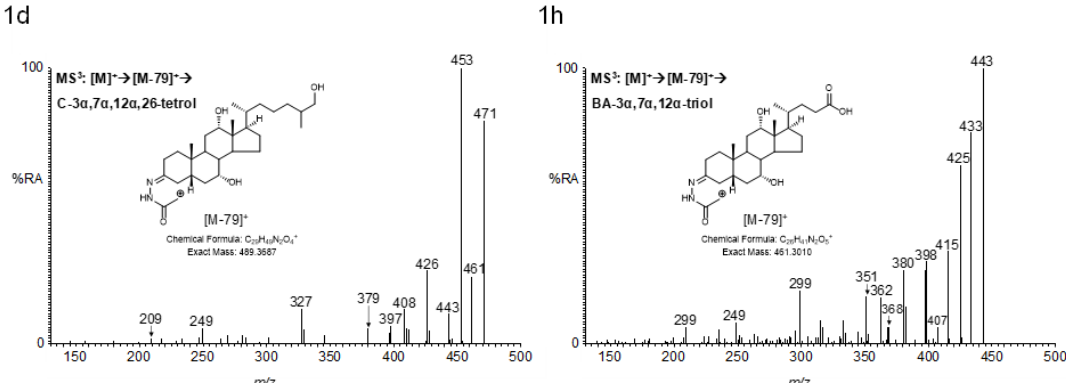
Figure 1. Reconstructed-ion chromatograms (RICs) and multistage fragmentation (MS 3 ) ([M] + → [M-Py] + → ) spectra of oxidized/GP-derivatized 3 α -hydroxy-5 β -bile alcohols and acids: ( a , b ) C-3 α ,7 α ,12 α -triol; ( c , d ) C-3 α ,7 α ,12 α ,26-tetrol; ( e , f ) CA-3 α ,7 α ,12 α -triol; ( g , h ) cholic acid. The RICs were generated from mass spectra recorded in the Orbitrap mass analyzer at a resolution of 120,000 (FWHM definition at m / z 400), with an m / z window of ± 5 ppm. MS 3 spectra were generated Mass accuracy for fragment ion measurements made with the linear ion-trap is typically ± 0.3 Da.